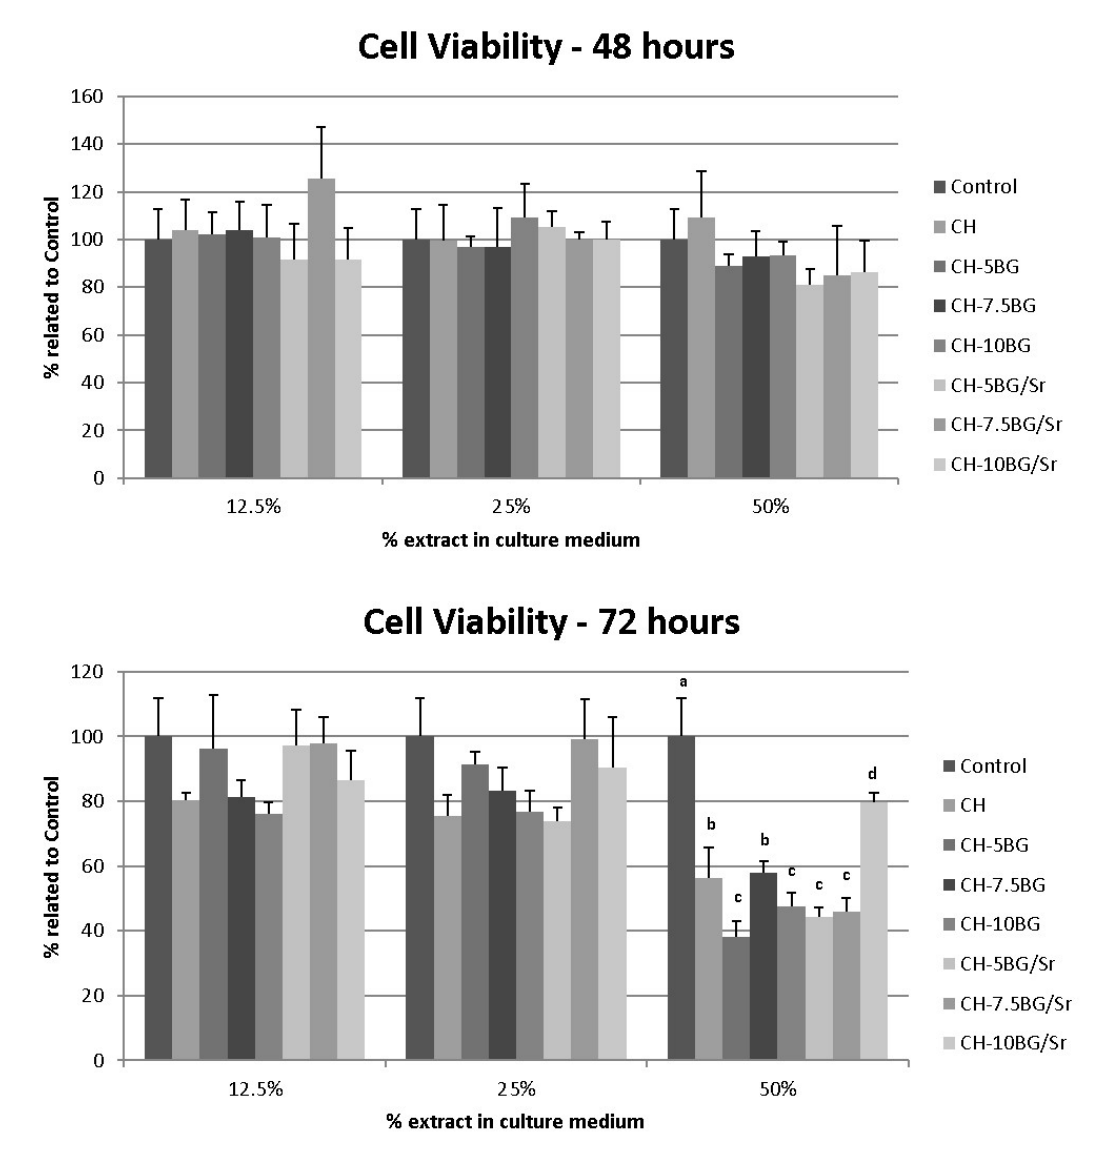
Figure 8. Cell viability test (MTT) in culture of pre-osteoblastic cells exposed to extracts of compositions based on calcium aluminate cement (CH) containing different contents of bioactive glass (BG) and strontium (Sr) in concentrations of 12.5%, 25% and 50% or in their absence (control) for 48 and 72 hours. Different letters between the samples (50%, 72 h) indicate a significant difference between groups at the same concentration (Kruskal Wallis/SNK, p<0.05). For all other results there was no statistical